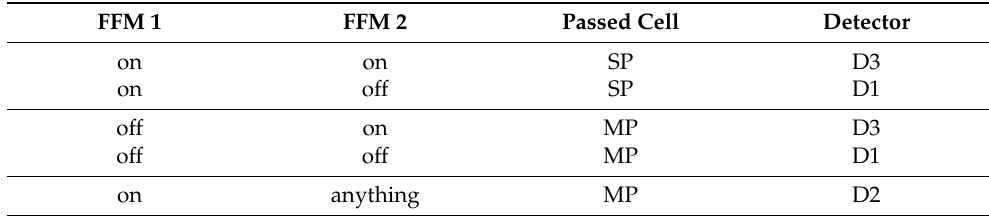
Figure 1. Optical layout and gas stream of the developed TF-NDIR spectrometer (EPC: electric pressure controller, M: mirror, FFM: flip flop mirror, OAP: off-axis parabolic mirror, BS: beam splitter, SP: single pass, MP: multi pass, D1: detector with wavelength tuning range (WTR) of 3.8–5.0 μ m, D2: detector with WTR of 5.5–8.0 μ m, D3: detector with WTR of 8.0–10.5 μ m. Table 1. Selection of gas cell and detector based on the combination of two flip flop mirrors (FFM). FFM operates with two statuses: “on” for a beam passing through and “off” for a reflected beam. The FFM1 status primarily affects the gas cell selection, whereas the FFM2 status primarily affects the detector